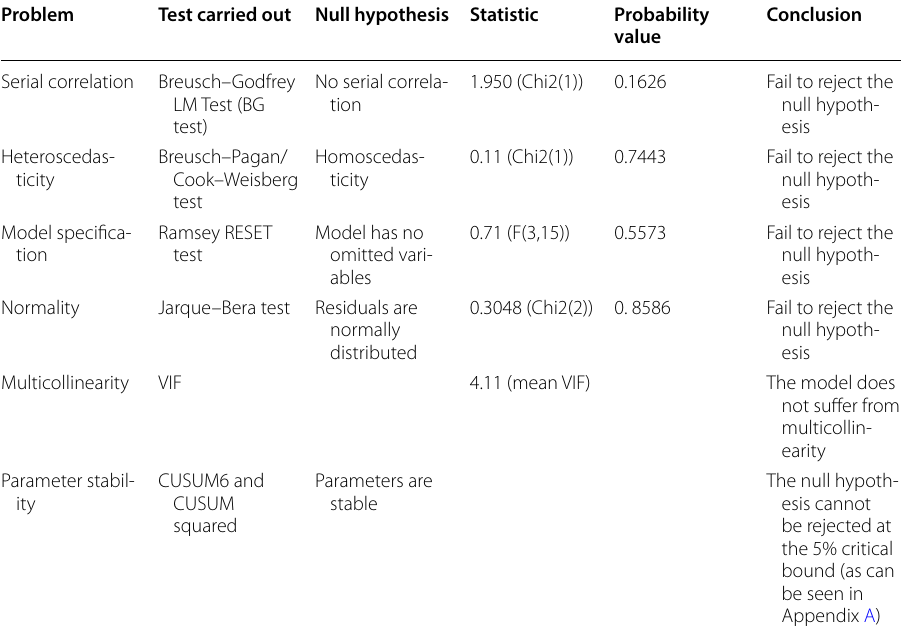
Table 4 Results of diagnostic tests carried out. Source: Author’s computation from World Development Indicators database for 2018